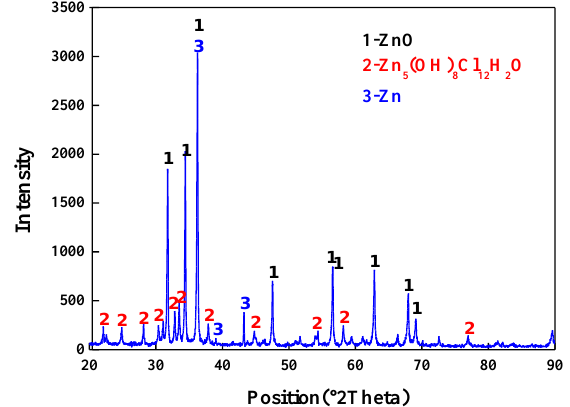
Figure 1. XRD pattern of zinc ash.